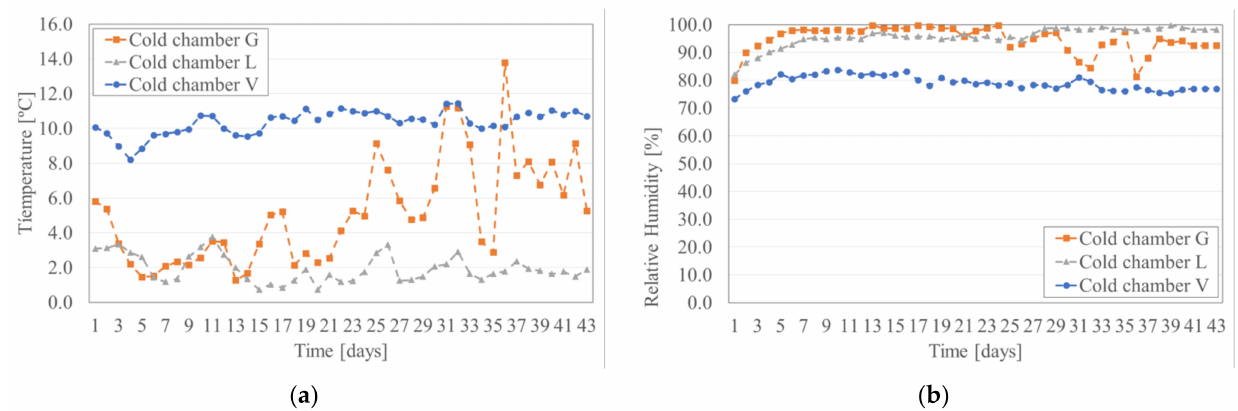
Figure 1. Measured extrinsic parameters in the cold chambers: ( a ) Air temperature ( ◦ C); ( b ) Relative humidity (%). Six sampling times ( t 7 , t 14 . t 21 , t 28 , t 35 and t 42 ) plus reference ( t 0 ) were used during the 42 days of the study. The index corresponds to the day (weekly frequency) that one sample